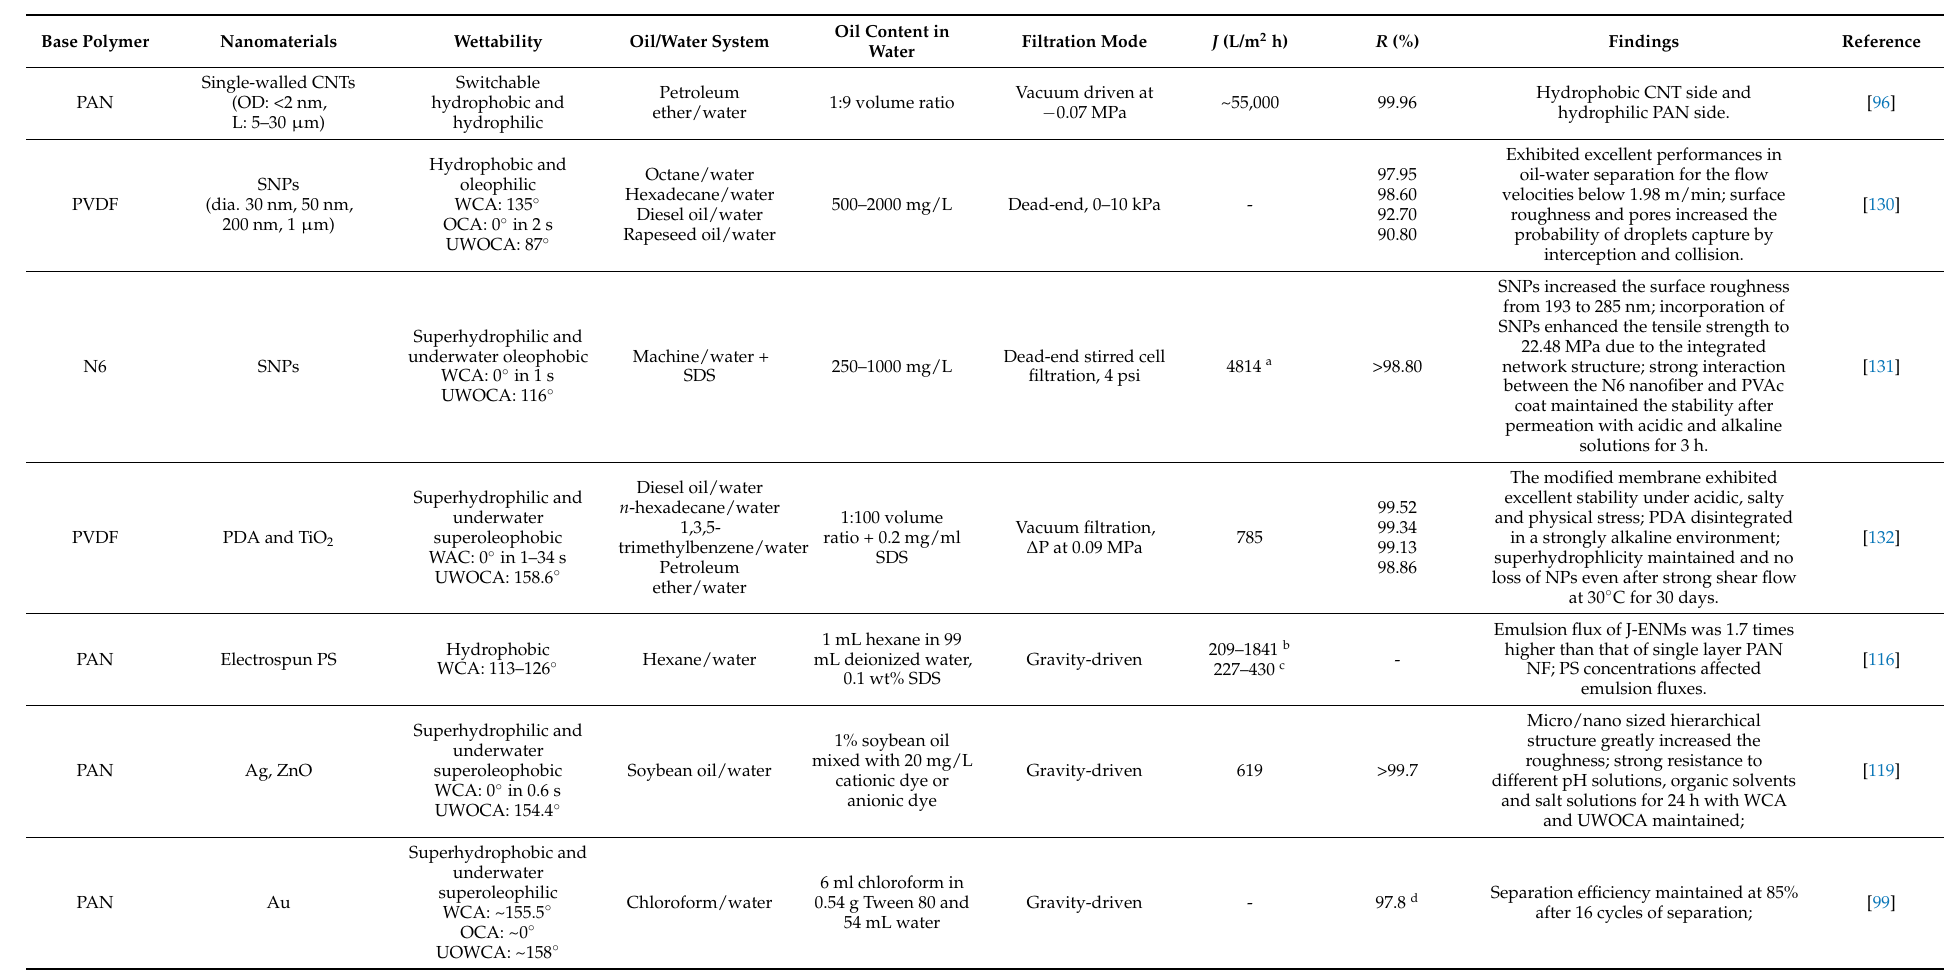
Table 4. Application of nanomaterials in the nanofiber membranes for oil/water emulsion